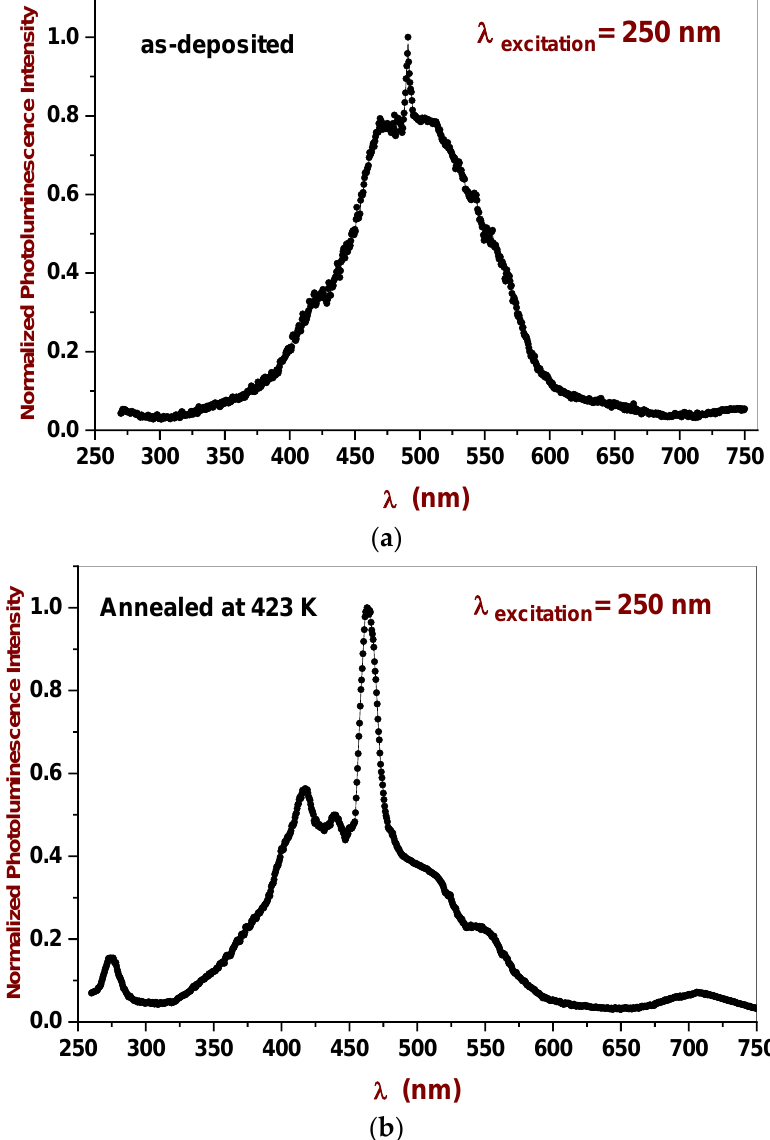
Figure 15. Normalized PL spectra of ( a ) as-deposited and ( b ) annealed compound 4 thin films.